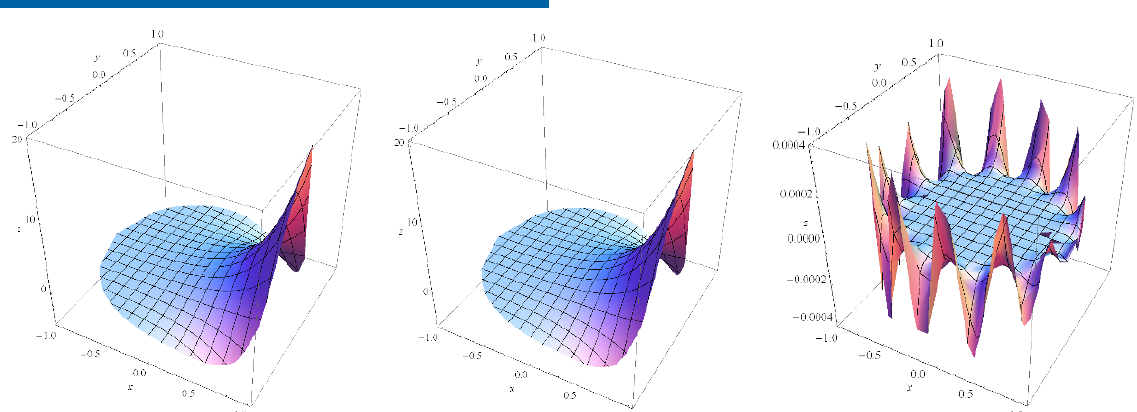
Figure 3. First example, n = 12 : function u , interpolant p , error u − p